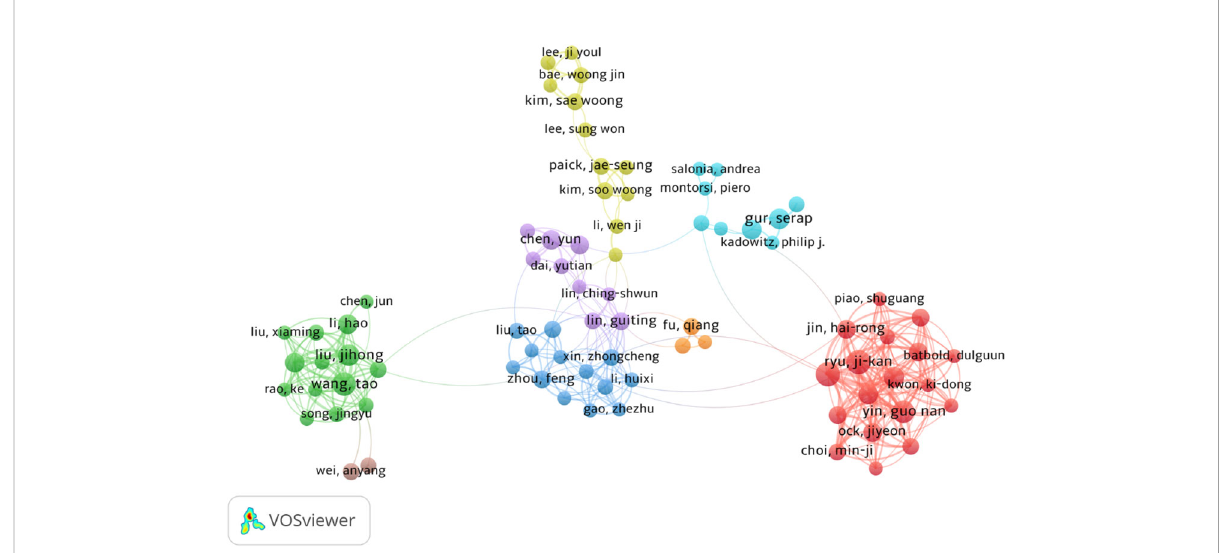
FIGURE 6 CiteSpace visualization map of authors involved in publications related to assisted reproduction. Nodes represent authors (the larger the circle, the greater the number of publications). The lines between nodes represent the cooperation between two authors of the same article (the wider the line, the more frequent the cooperation). The node color represents the year.